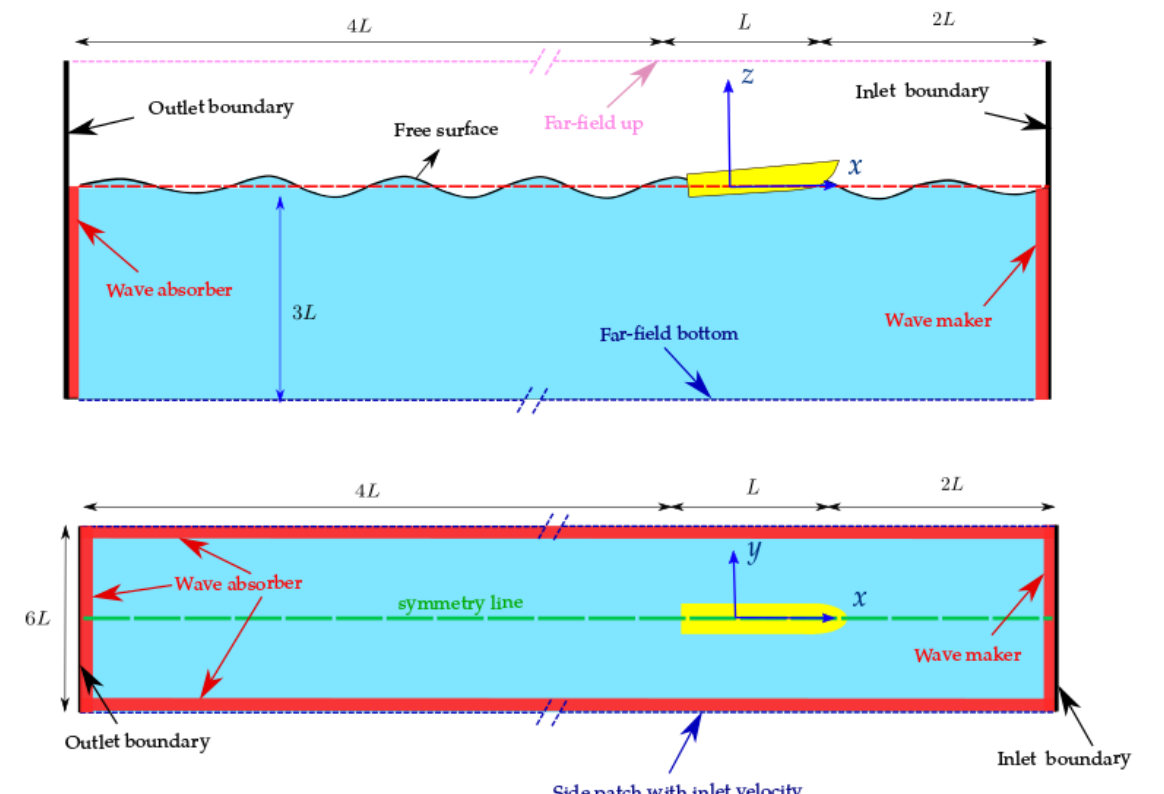
Figure 1. A sketch showing the problem domain. A tunneled planing craft is subjected to gravity waves that are generated by the numerical wave-maker that is located at the right end of the domain. The upper and lower panels show the longitudinal and top views of the problem. The dimensions of the domain are chosen based on the previous CFD simulations and recommendations, and their values are mentioned in Section 3 of the paper where the CFD model is described.